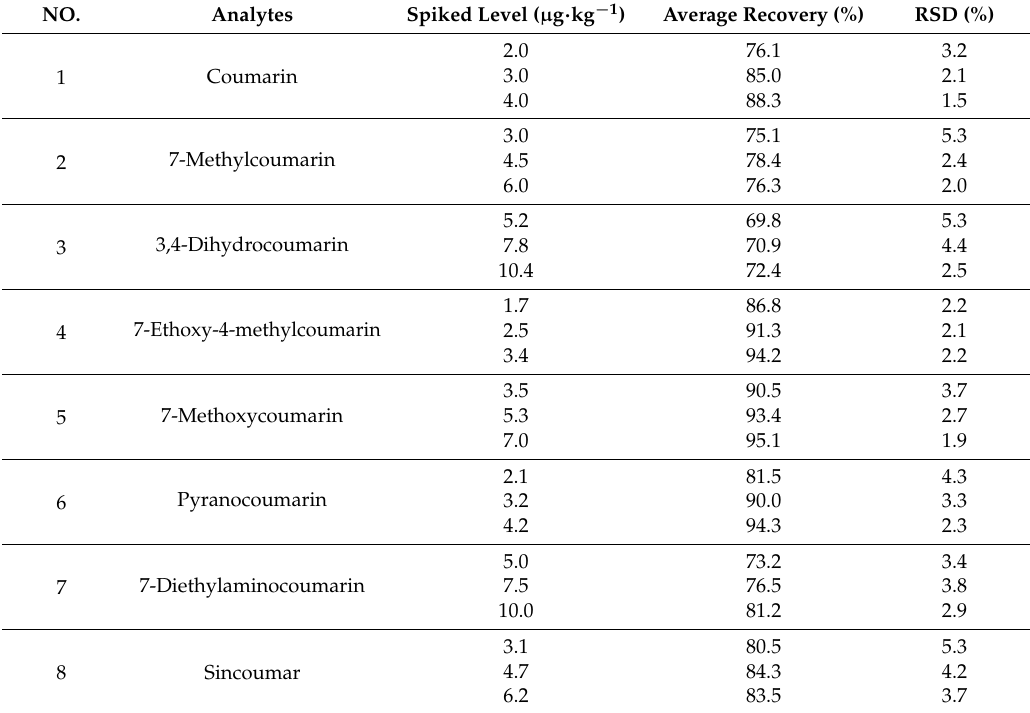
Table 3. Recovery and precision of the investigated compounds.